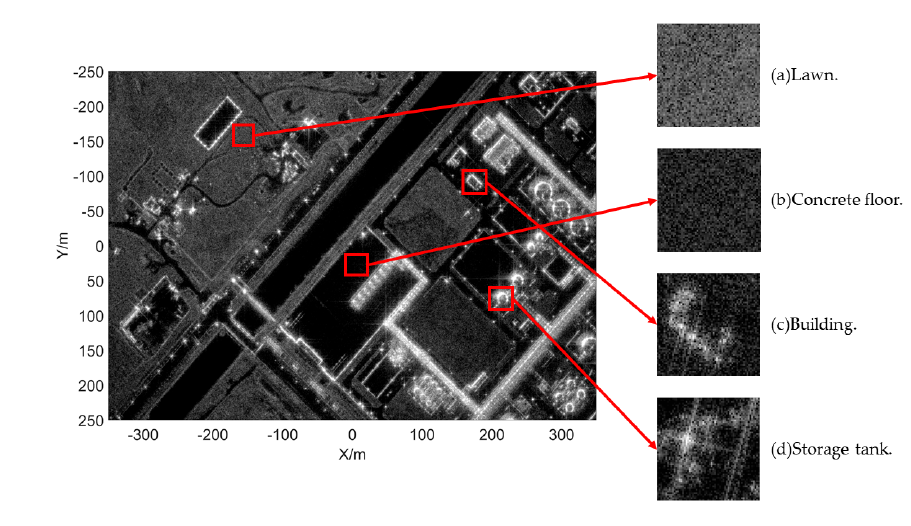
Figure 6. The sub-aperture images of chosen areas. ( a ) Lawn. ( b ) Concrete floor. ( c ) Building. ( d ) Storage tank.